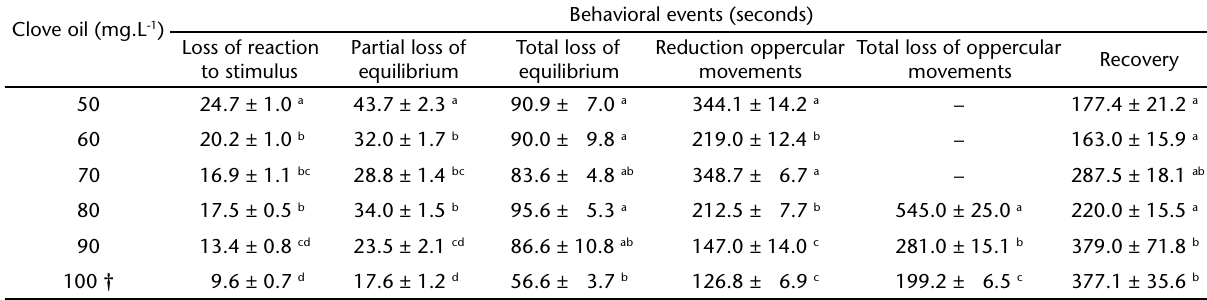
Table I. Induction times, to the different anaesthesia stages in O. niloticus juveniles exposed to different concentrations of clove oil. Behavioral events adapted from S TOSKOPF (1993). Different letters in the columns indicate statistical difference between concentrations in one same anaesthesia stage by the ANOVA and Tukey test